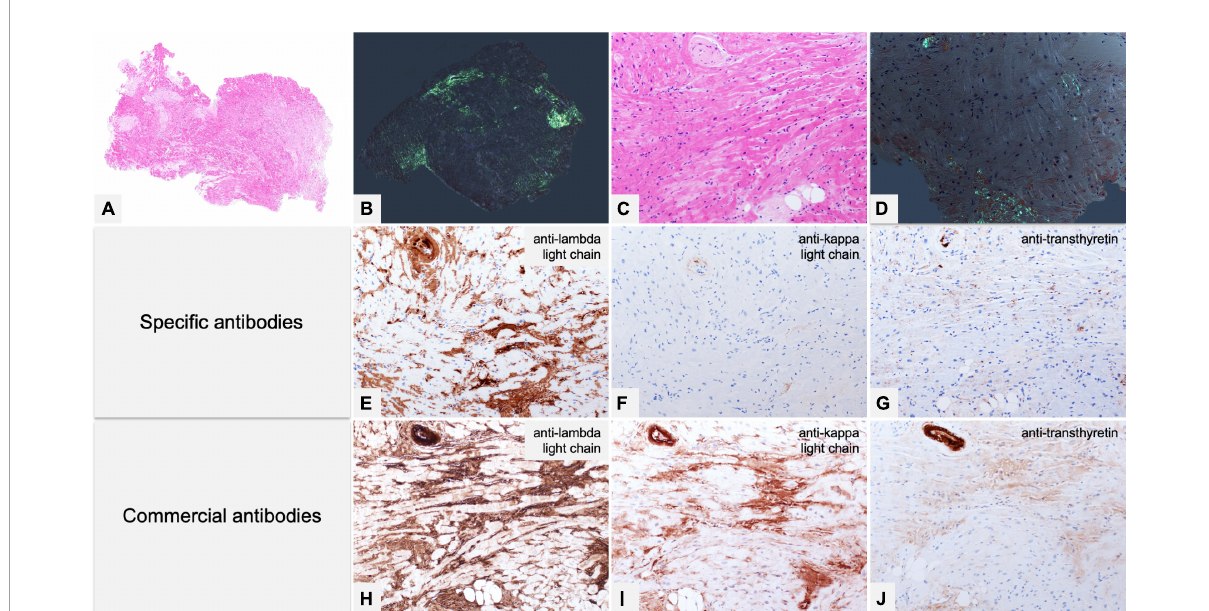
FIGURE7 Endomyocardial biopsy of a 55-year-old male patient performed for clinically unexplained cardiopathy/cardiomyopathy. (A–D) Histology shows amyloid deposits within vessels and myocardial interstitium, clearly evident with Congo red birefringence (B,D) . (E–G) Immunohistochemistry with specific antibodies was suggestive of AL, as it showed strong immunostaining for lambda light chain in vessel and myocardial deposits, and substantial negativity for kappa light chain and TTR. (H–J) Immunohistochemistry with commercial antibodies was inconclusive: all three antibodies showed strong immunostaining of the artery, although myocardial interstitial amyloid deposits were particularly strong only with anti-lambda light chain, partially due to background. Fibril protein typing with mass spectrometry in tandem mode was positive for lambda light chain proteotypic peptides. Subsequent hematological study led to diagnosis of lambda light chain monoclonal gammopathy of undetermined significance and related AL principally localized in the heart. (A) Hematoxylin-Eosin 50 × . (B) Congo red under polarized light, 50 × . (C) Hematoxylin-Eosin 200 × . (D) Congo red under polarized light, 200 × . Specific antibodies (amY-kit reduced PeloBiotech): (E) Anti-lambda-UTI/LAT (200 × ). (F) Anti-kappa-KRA/KUN (200 × ). (G) Anti-ATTR-TIE (200 × ). Commercial antibodies against native proteins. (H) Anti-lambda Roche-Ventana (200 × ). (I) Anti-kappa Roche-Ventana (200 × ). (J) Anti-ATTR AbCam clone EP2929Y (200 ×